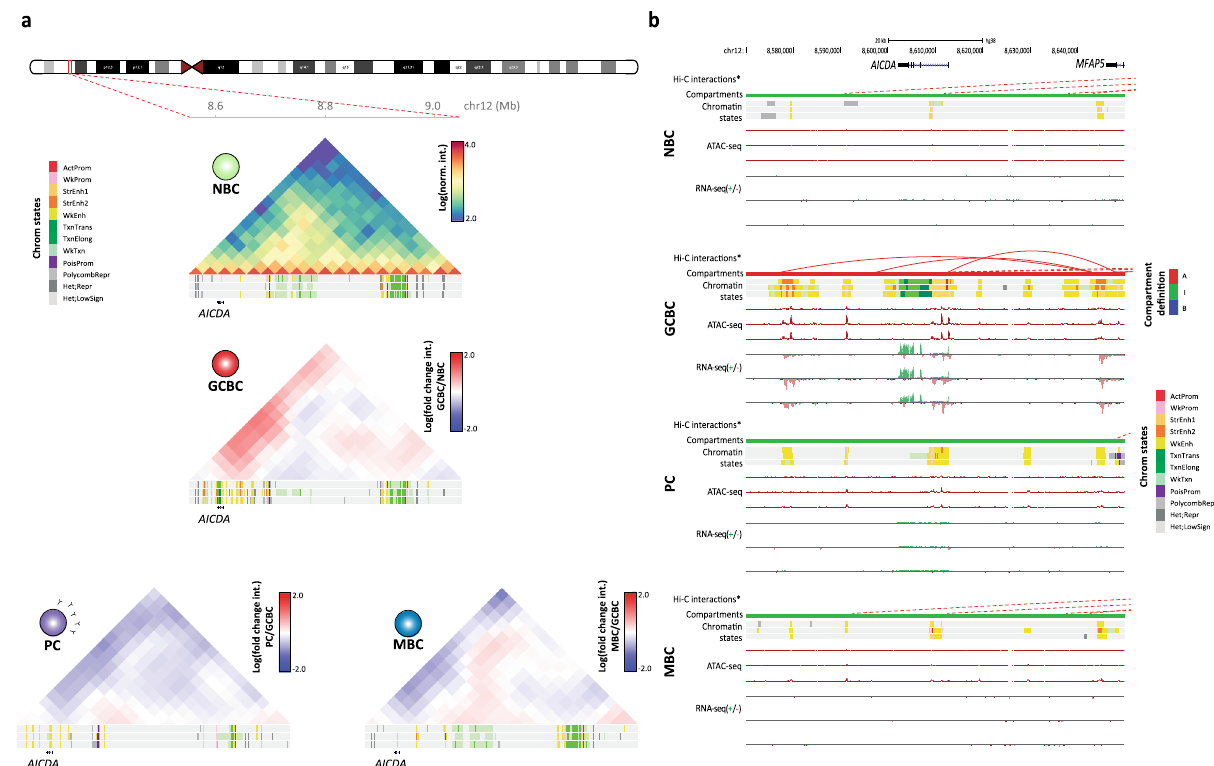
Fig. 3 Chromatin organization at the AICDA locus. a Normalized Hi-C contact map of the domain structure surrounding the AICDA gene (chr12:8,598,290-8,615,591, GRCh38) in NBC. The log fold change interaction between GCBC, MBC, or PC as compared to NBC was computed. Below each interaction map, chromatin state tracks of three biological replicates per B cell subpopulation are shown. The coordinates of the represented region are chr12:8,550,000 – 9,050,000, GRCh38. b Multi-layer epigenomic characterization of the AICDA gene region in four B cell subpopulations. Arc diagrams indicate signi fi cant Hi-C interactions (continuous red lines involve the region of interest, while dashed red lines involve other regions of chromosome 12). Below them, compartment de fi nition (red, compartment A-type: green, compartment I-type), chromatin states, chromatin accessibility (ATAC-seq, y -axis signal from 0 to 105), and gene expression (RNA-seq, y -axis signal from 0 to 4 for the positive strand and from 0 to − 0.1 for the negative strand) are shown. Tracks of Hi-C interactions and compartment de fi nition are based on merged replicates whereas chromatin states, chromatin accessibility, and gene expression tracks of each replicate are shown separately. The coordinates of the represented region are chr12:8,570,000 – 8,670,000,